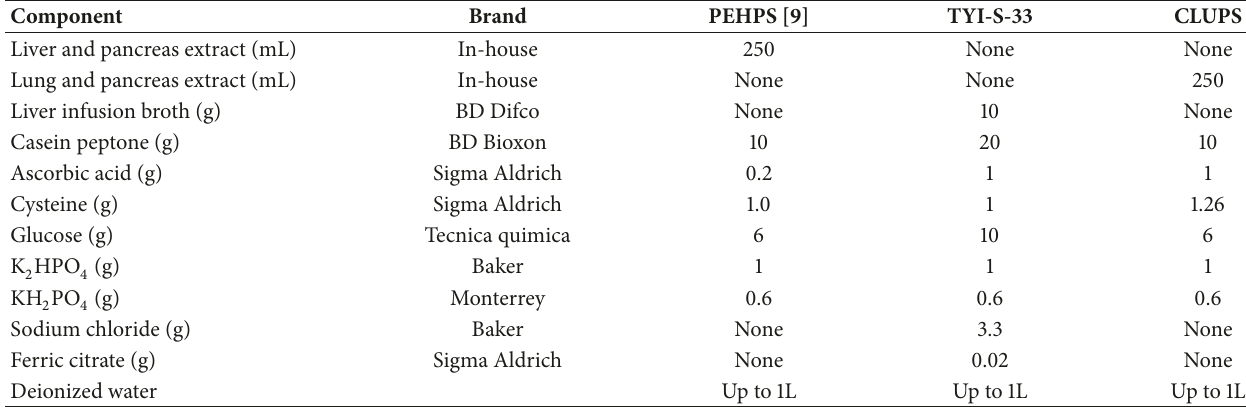
Table 1: Composition of the culture media, PEHPS, TYI-S-33, and CLUPS.